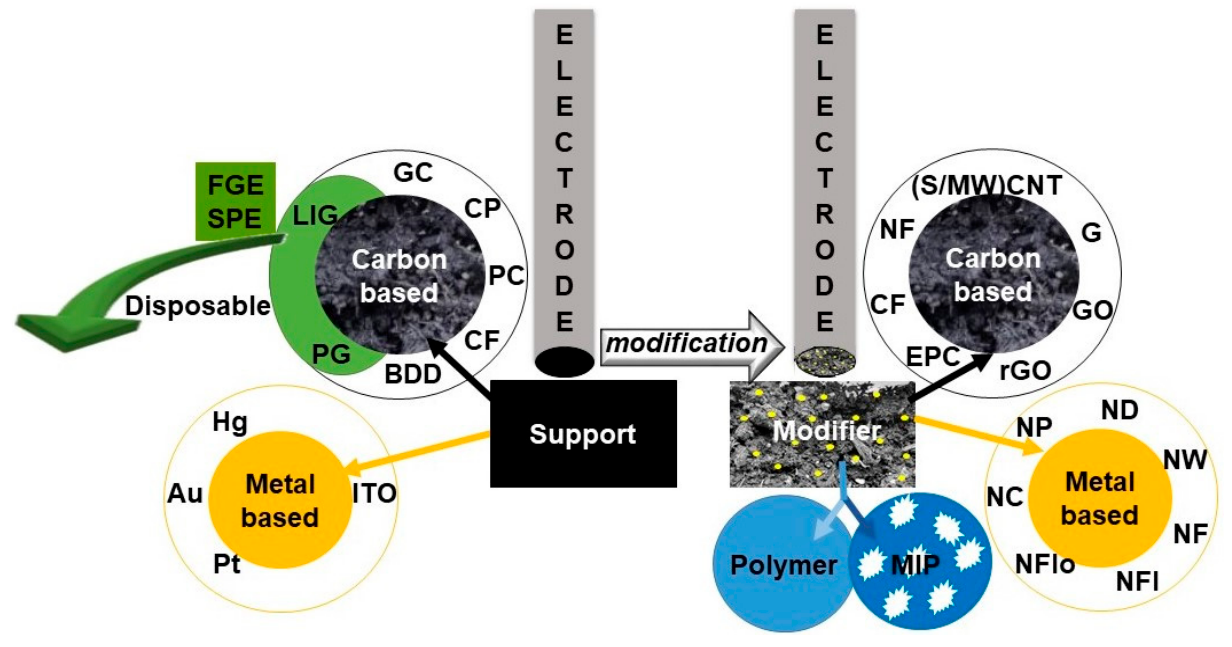
Figure 2. Illustration of electrode supports and modifiers employed in the sensors prepared for amphenicol analysis. Table 1. The performance characteristics of electrochemical sensors reported in the literature for amphenicol determination.